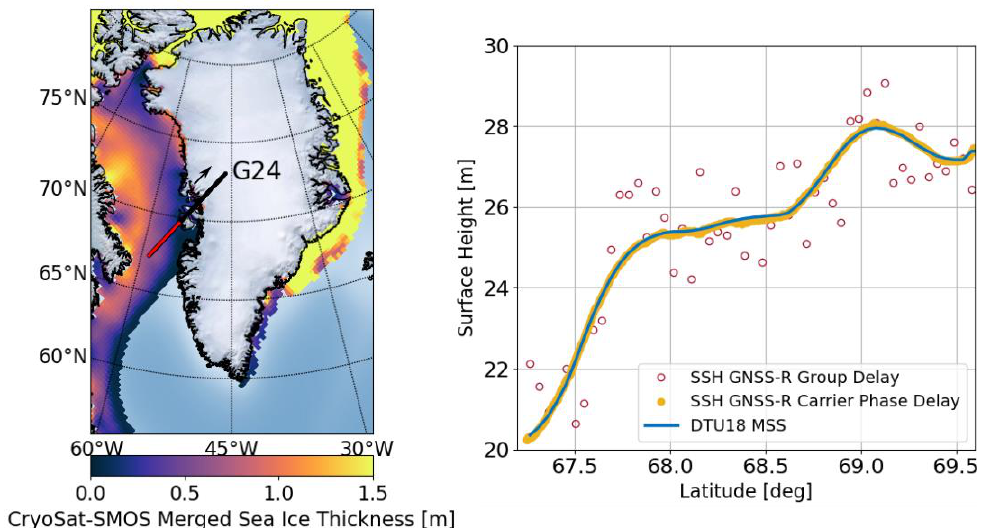
Figure 8. An example of GNSS-R altimetry results over sea ice. The complex waveform is generated from the raw IF data collected by the TDS-1 satellite on 27 February 2016. The GNSS transmitter is GPS PRN 24. Left : Sea ice thickness and specular point track. The black line is the ground track of the speuclar point, with the red segment indicating the region with coherent reflections. Right : Comparison between the altimetry results and the DTU18 mean sea surface